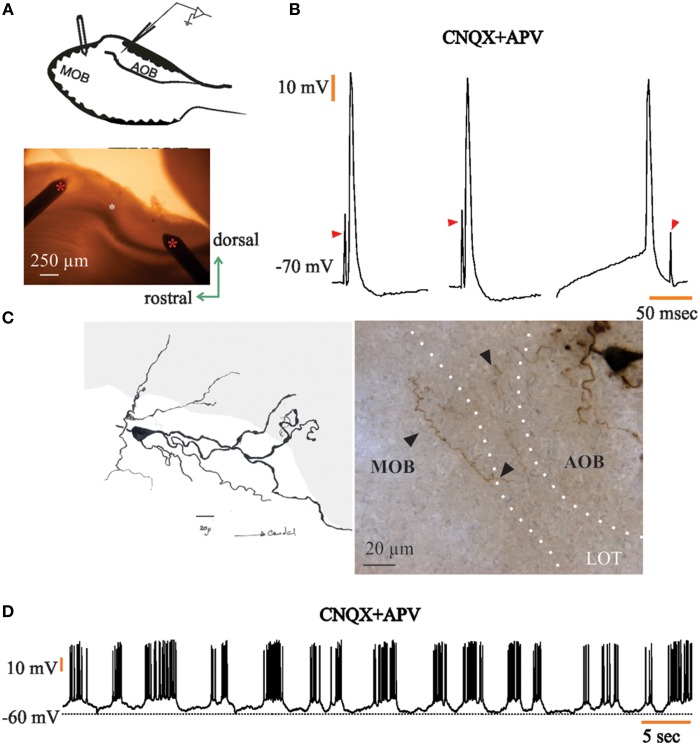
Large principal cells of the anterior half of the accessory olfactory bulb (aAOB) send axon collaterals to the dorsal main olfactory bulb (MOB). (A) Schematic of the recording setup (up) and picture taken the day the neuron in c was recorded (red asterisks, stimulating electrodes; white asterisk, tip of the recording electrode). (B) Antidromic action potentials elicited by dorsal-MOB stimulation (left); the evoked antidromic responses persist in the presence of 20 μM of CNQX and APV (center); collision tests annihilated the evoked response (right); arrowheads indicate stimulating artifact. (C) Drawing (left) and photomontage (right) of the LPC recorded; note that the axon (arrowheads) that has been omitted in the drawing leaves aAOB territory and heads toward the MOB. Orientation is the same as in a. (D) The neuron recorded fires rhythmic bursts of action potentials in the presence of CNQX and APV (20 μM).